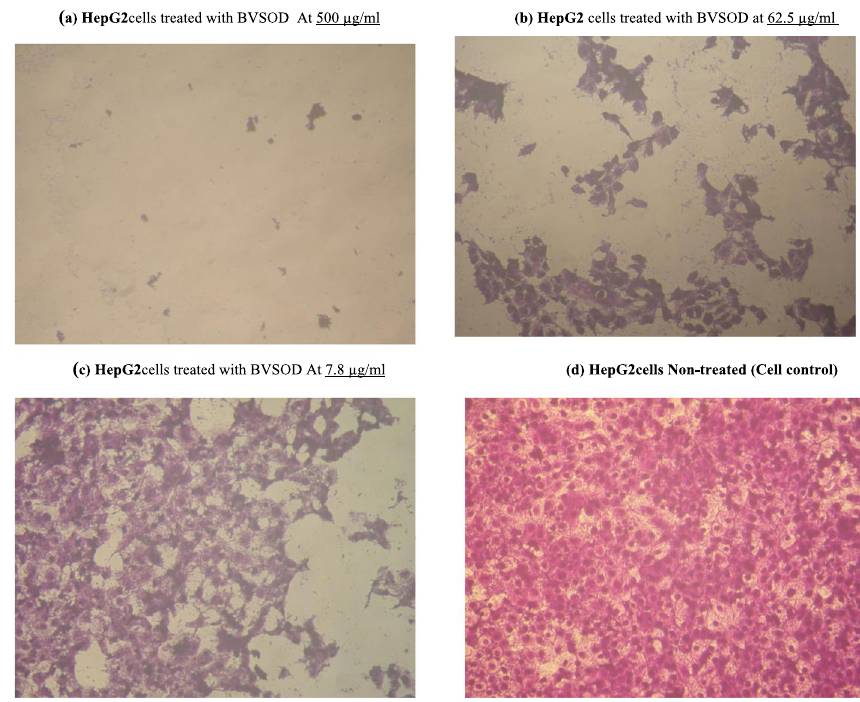
Fig. 7 Morphological evaluation of cytotoxicity of purified BVSOD against HepG2 cell line using different concentrations and compared with HepG2 non‑treated cell as a control. a HepG2 cells treated with BVSOD at 500 µg/ml. b HepG2 cells treated with BVSOD at 62.5 µg/ml. c HepG2 cells treated with BVSOD at 7.8 µg/ml. d HepG2cells non‑treated (cell